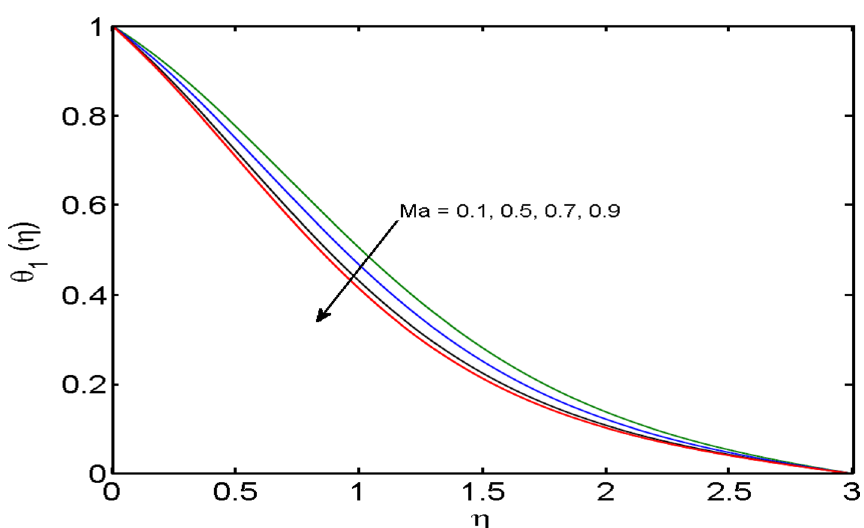
Figure 14. θ 1 (η) versus varied estimates of M a